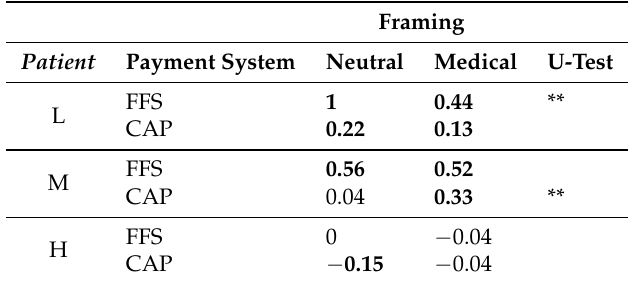
Table A2. Misreporting between neutral and medical framing.